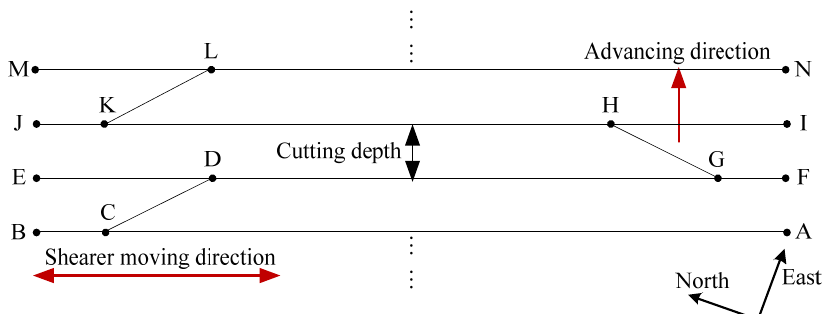
Figure 3. The simplified shearer trajectory.